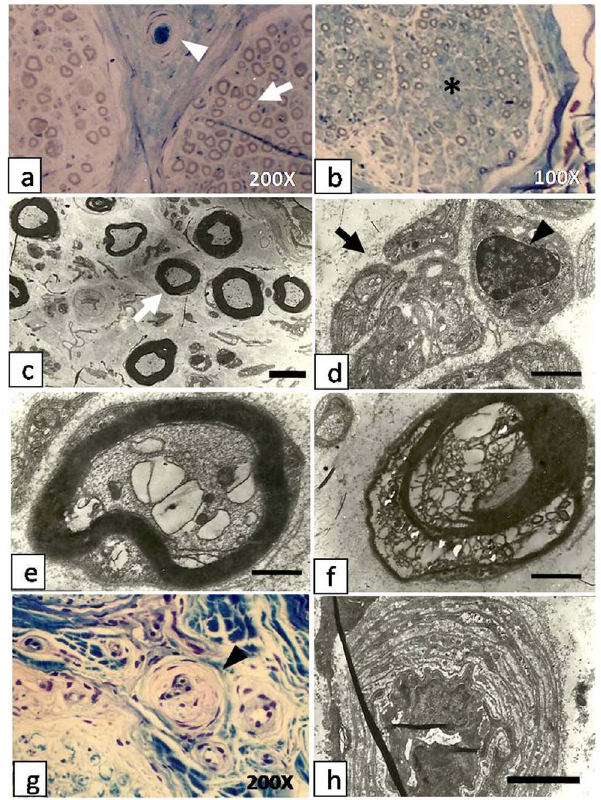
Figure 2. Cross section biopsies of sural nerves in patients with diabetic peripheral neuropathy. a. Semi-thin section of sural nerve of case5 shows mild reduction in the number of nerve fibers (white arrow), and an arteriole plugged by a thrombus(white arrowhead). b. Semi-thin sections of sural nerve from case 1 shows severe loss of myelinated axons and increased endoneurial collagen (asterisk). C. and d. Semi-thin sections showdegeneration and regeneration of myelina- ted (white arrow) and unmyelinated (black arrow) fibers and proliferation of Schwann cells (black arrowhead) (case 3 and 6). e. and f. Semi-thin sections of a single myelinated axon showdegenerating myelin sheaths, absence of lamellar structures and balloon cell degeneration of the neuronal body (e: case 3); the axon shows almost complete structural disintegration (f: case 1). g. Section stained by Toluidine blue and examined by light microscopy shows luminal